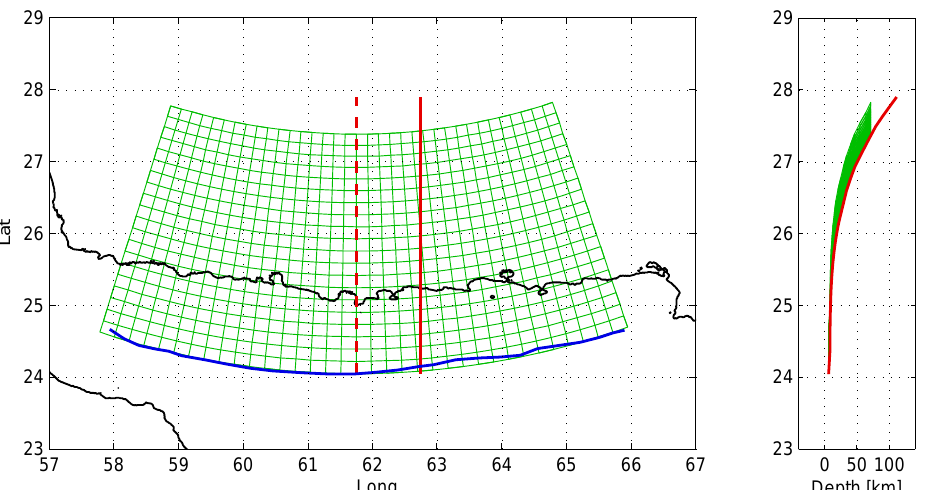
Figure A1. Profile (red) and deformation front (blue) as from Smith et al. (2013) and constructed 3d geometry (green) as used in the present